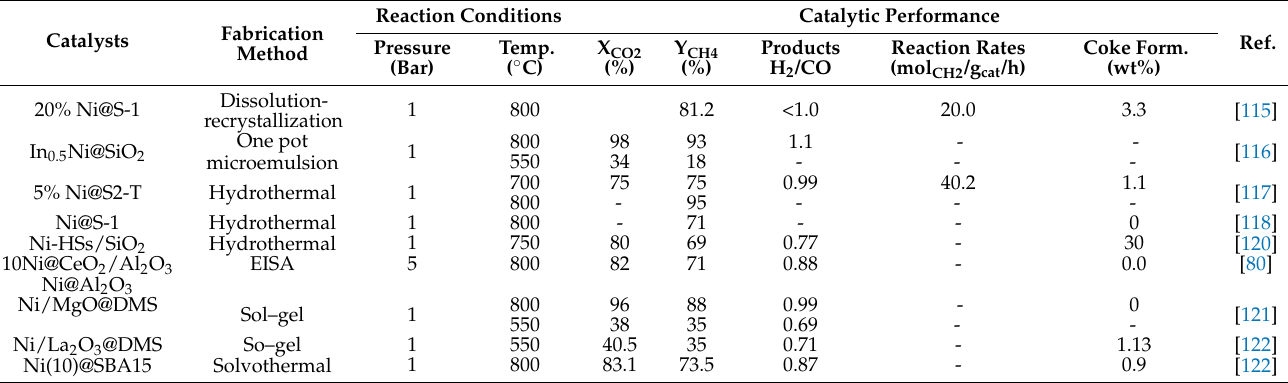
Table 3. Summary of catalytic performance of core-shell in